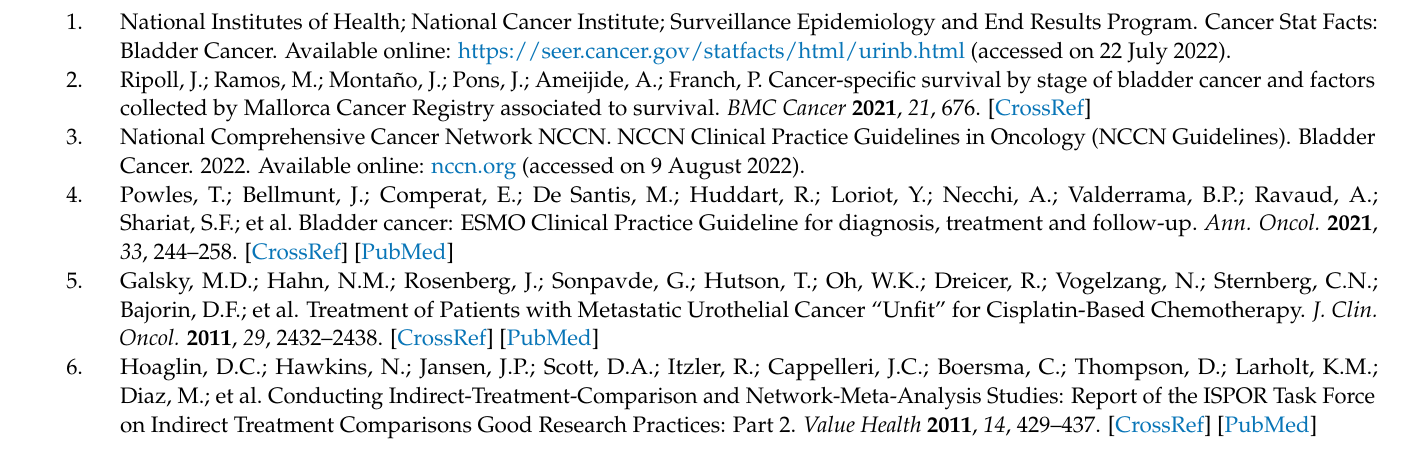
Figure S3: Median OS for SOC (GemPlat) in the cis-eligible/mixed network [37,38]; Figure S4: Median OS for SOC (GemCarbo) in the cis-ineligible (wide) network [39]; Figure S5: Median OS for SOC (GemCarbo) in the cis-ineligible (strict) network; Figure S6: Median PFS for SOC (GemPlat) in the cis-eligible/mixed network; Figure S7: Median PFS for SOC (GemCarbo) in the overall cis-ineligible networks. Table S1: Cochrane risk-of-bias tool for randomized trials (RoB2); Table S2: Overview of studies in each network [25]; Table S3: League table of relative treatment effects on OS (HR, Crl). Cis-eligible/mixed network; Table S4: League table of relative treatment effects on OS (HR, Crl). Cis-ineligible (wide) network; Table S5: League table of relative treatment effects on OS (HR, Crl). Cis-ineligible (strict) network; Table S6: League table of relative treatment effects on PFS (HR, Crl), Cis-eligible/mixed; Table S7: League table of relative treatment effects on PFS (HR, Crl). Cis-ineligible (wide) network; Table S8: League table of relative treatment effects on PFS (HR, Crl). Cis-ineligible (strict) network. Additional references